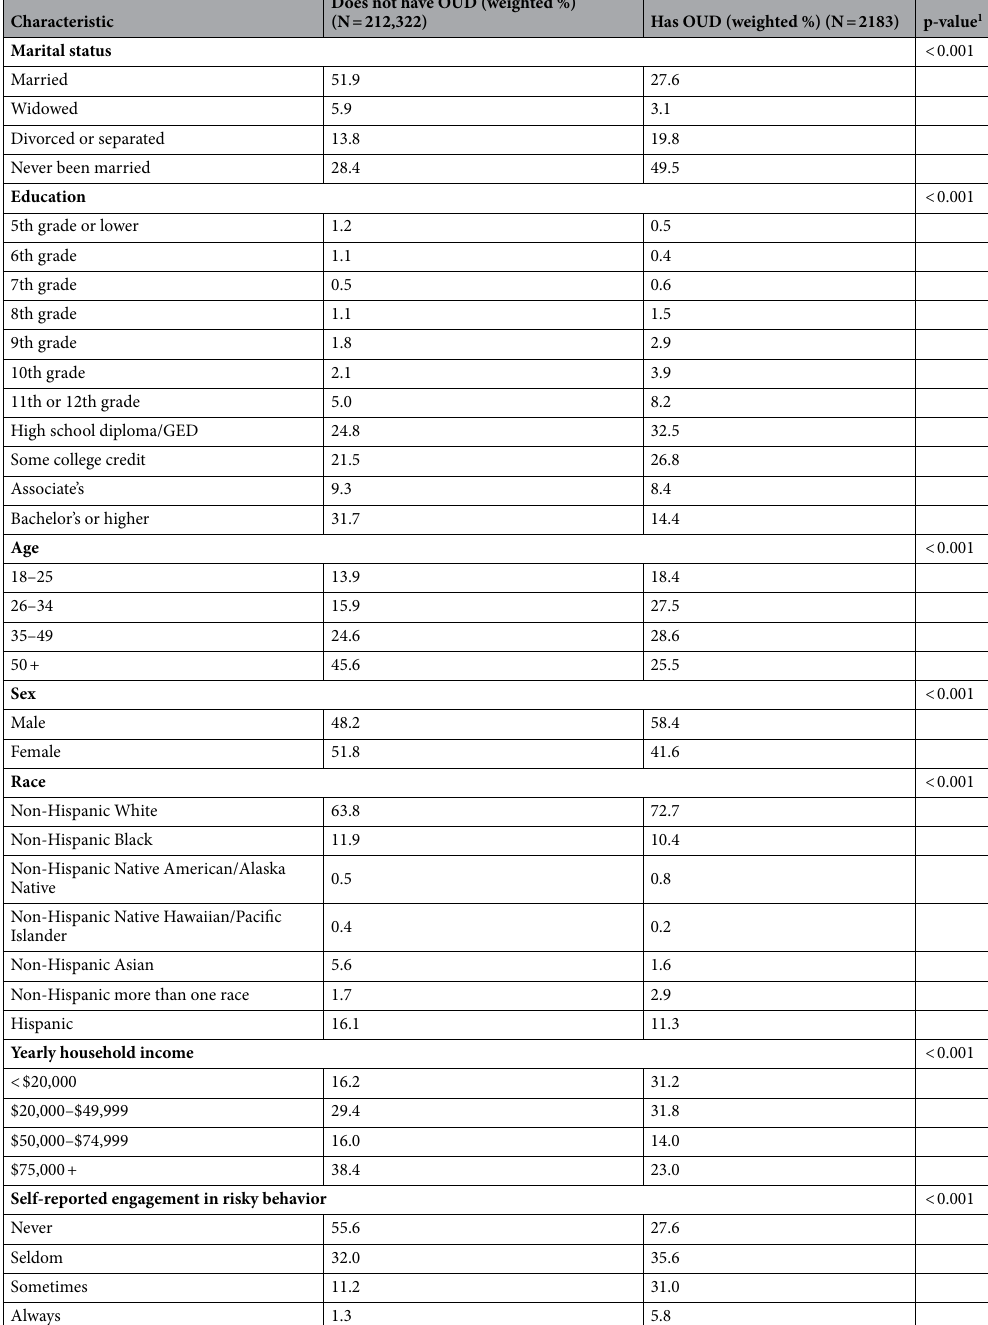
Table 1. Demographics of those with versus without opioid use disorder (OUD). 1 Chi-squared test with Rao and Scott’s second-order